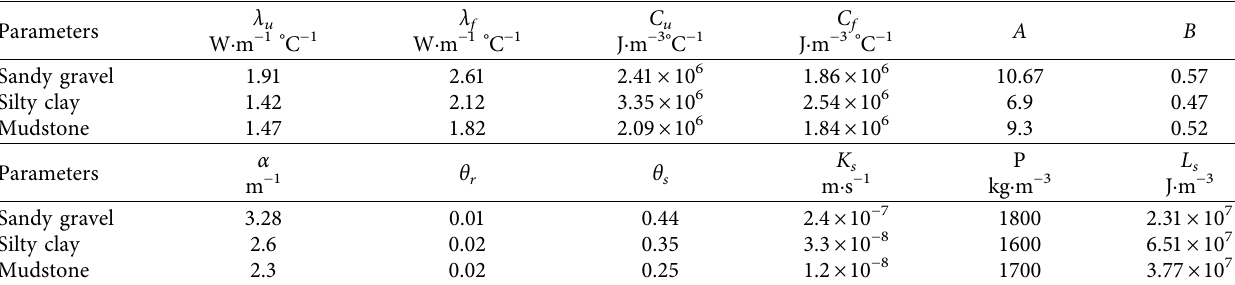
Table 1: Thermal and hydraulic parameters of the three soil layers.